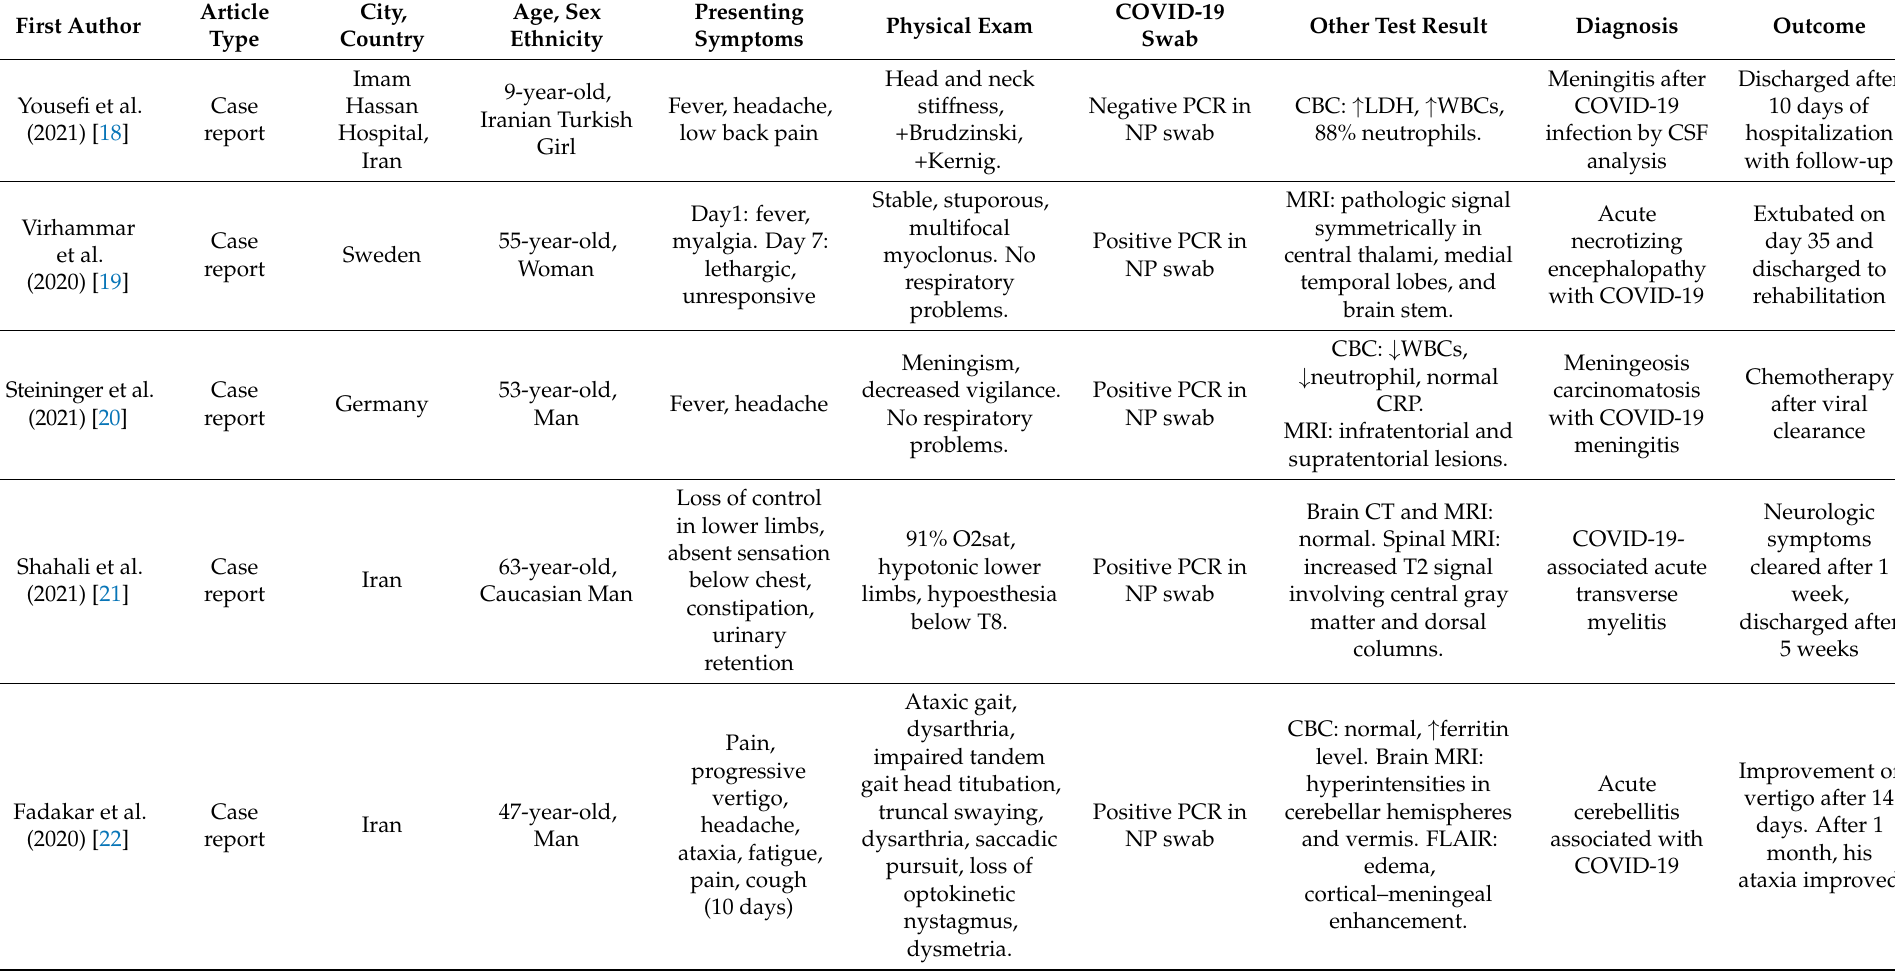
Table 1. Characteristics of included confirmed COVID-19 CSF